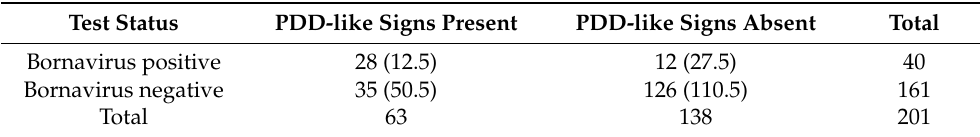
Table 3. Cross table for the number of canaries with or without proventricular dilatation disease (PDD)-like signs and bornavirus test results. X 2 (1, n = 201) = 34.68, p < 0.001, ϕ = 0.415. Expected counts for perfectly independent variables are given in brackets.